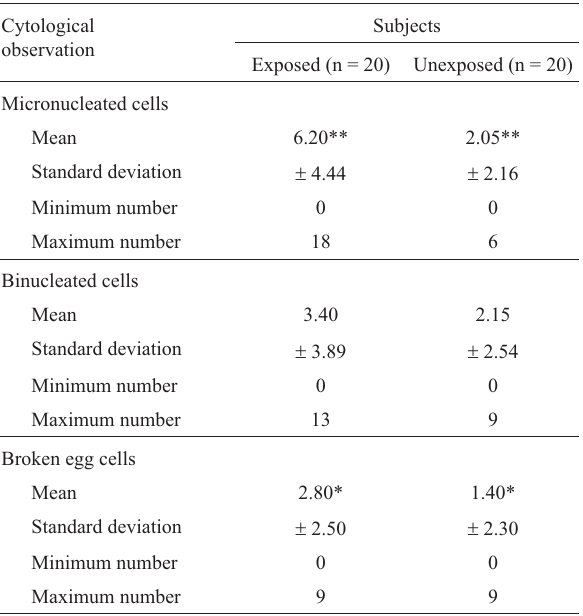
Table 2 - Cytological observations made on 10 males and 10 females occupationally exposed to cathode ray tube computer video display monitors (VDMs) as compared to unexposed control individuals matched for age and sex. We assessed 2,000 cells for each individual. Cytological observation